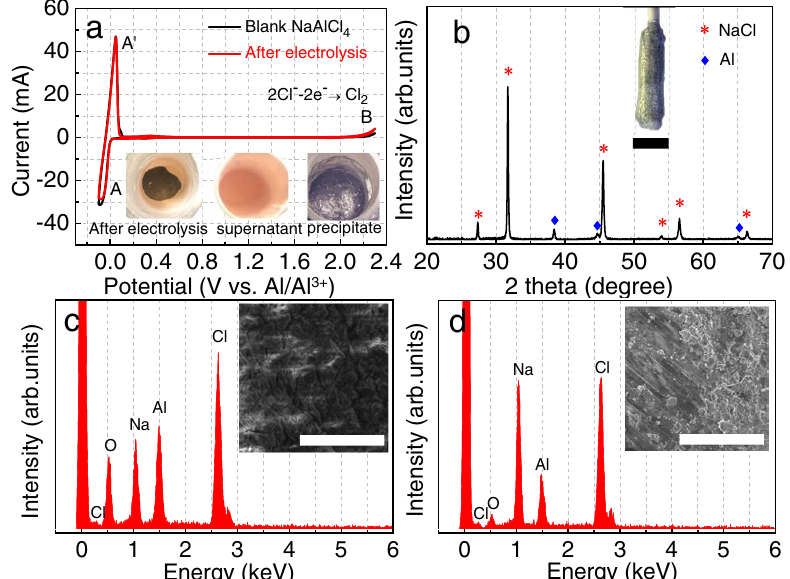
Fig. 3 Analyses of electrolyte and cathode after IAP. a CV curves of NaAlCl 4 melt before (black line) and after electrolysis (red line); insets are photos looking down into the anode crucible after electrolysis, and of the separated supernatant and precipitate. b XRD pattern of the cathode product after electrolysis, with a photo of the cathode. Typical EDS analyses of c electrolyte and d cathode product after electrolysis; insets are the corresponding SEM images. The scale of b is 1 cm and c , d is 100 µ m. reveals crystalline product UCl 3 , with no apparent side reactions even for an anodic oxidation potential above that for evolution of Cl 2 (2.30 V vs. Al shown in Fig. 3a). Extended X-ray absorption fi ne structure (EXAFS) characterization (Fig. 2e and Supple- mentary Fig. 2, Supplementary Table 1) of the IAP anodic pre- cipitate after electrolysis at 3 V provided the U oxidation state and local coordination environment 24,25 in good agreement with XRD (Fig. 2f). Given that U 3 + is typically oxidized to U 4 + at such a high potential, this result suggests U 3 + is trapped in the pre- cipitate, preventing its further oxidation. NATURE COMMUNICATIONS| (2021) 12:5777